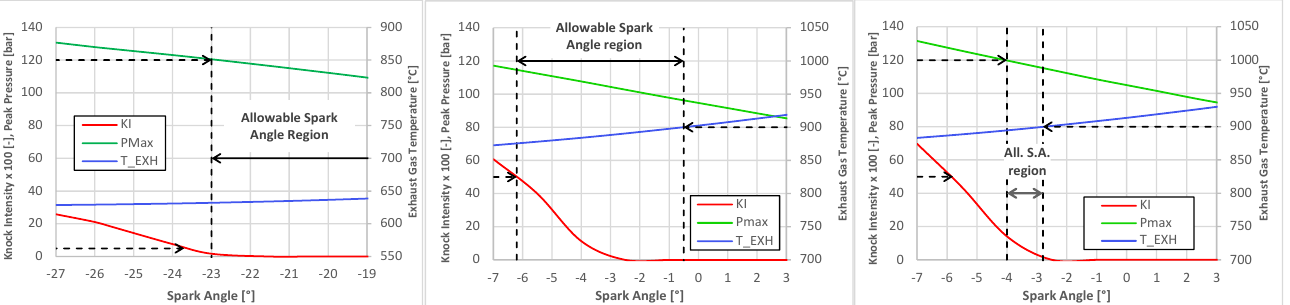
Figure 4. Exhaust Gas temperature, in-cylinder pressure peak and knock intensity versus spark angle. ( Left ): boost = 2.6 bar, φ = 0.5; ( middle ): boost = 2.3 bar. φ = 0.8; ( right ): boost = 2.6 bar, φ = 0.8. Engine running at 3000 rpm.